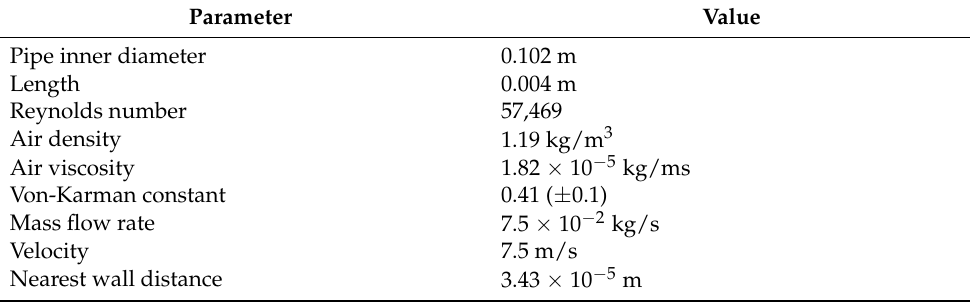
Table 3. Parameters for the